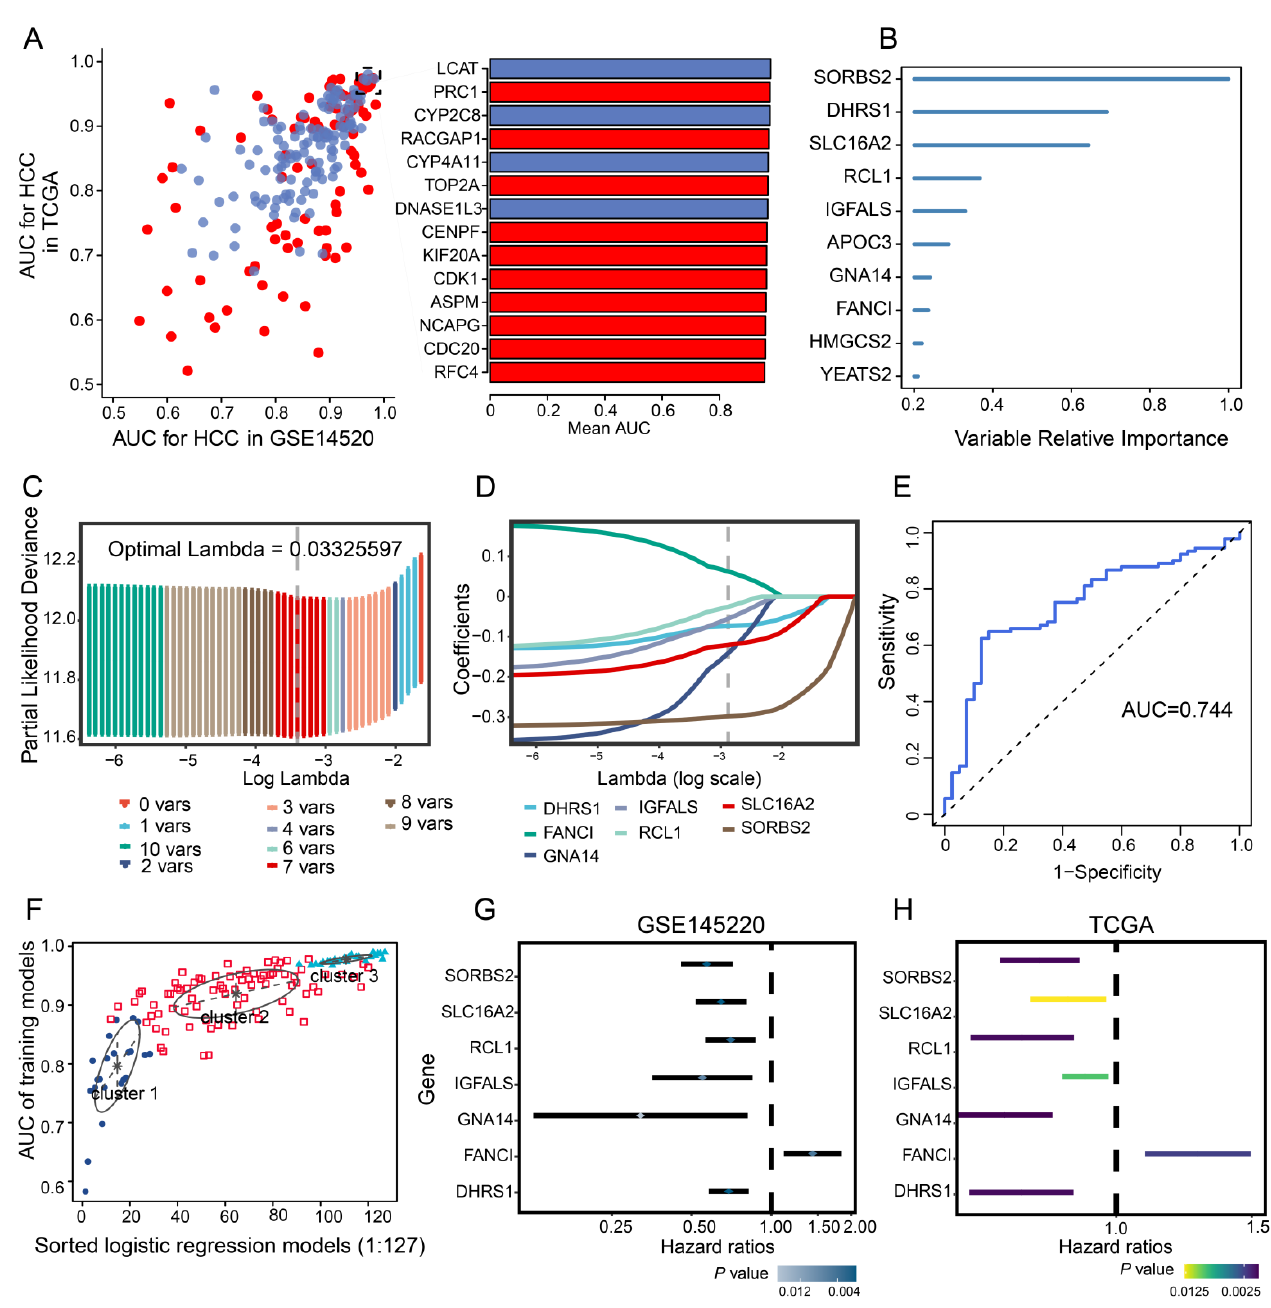
Figure 3. Univariate Cox and LASSO regression. ( A ) Evaluation of the diagnostic value of overlapping differentially expressed genes based on AUC. The 14 genes shown (red, upregulated; blue, downregulated) had AUCs >0.95. ( B ) Survival-related genes identified by univariate Cox regression analysis of 138 prognostic genes with AUC >0.80. ( C ) LASSO coefficient profiles of the 10 survival-related genes. ( D ) Ten-fold cross-validation of parameter selection in the LASSO model. ( E ) Time-dependent receiver operating characteristic curves of 5-year overall survival in HCC based on the seven feature genes. ( F ) Pattern of the Gaussian finite mixture model correlated with the AUC scores. There were three clusters of 127 combinations. ( G , H ) Univariate analysis of feature genes in the ( G ) GSE14520 and ( H ) TCGA datasets. AUC, area under the receiver operating characteristic curve; HCC, hepatocellular carcinoma; LASSO, least absolute shrinkage and selection operator; TCGA, The Cancer Genome Atlas.